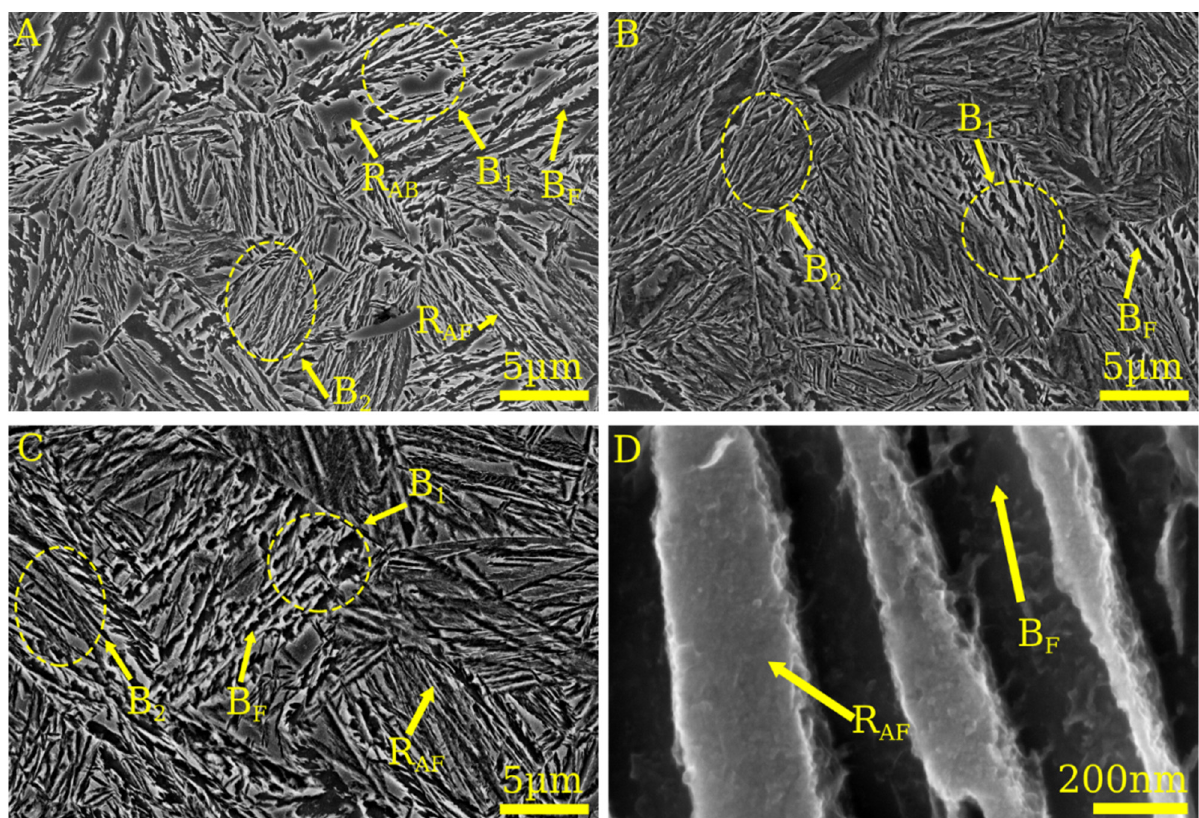
Figure 7. ( A – C ) SEM micrograph of the sample treated according to route MULTISTEP 1, MULTISTEP2, MULTISTEP3, respectively. ( D ) High magnification SEM micrograph showing filmy of retained austenite and bainitic ferrite. B1: carbide- free bainite formed during the first isothermal holding step; B2: carbide-free bainite formed during the second isothermal holding step. RAF: retained austenite film; BF: bainitic ferrite; RAB: retained austenite block; M: